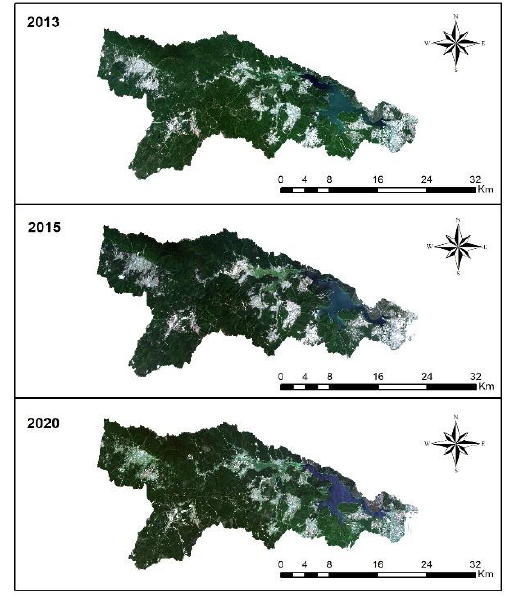
Figure 2. Satellite Images